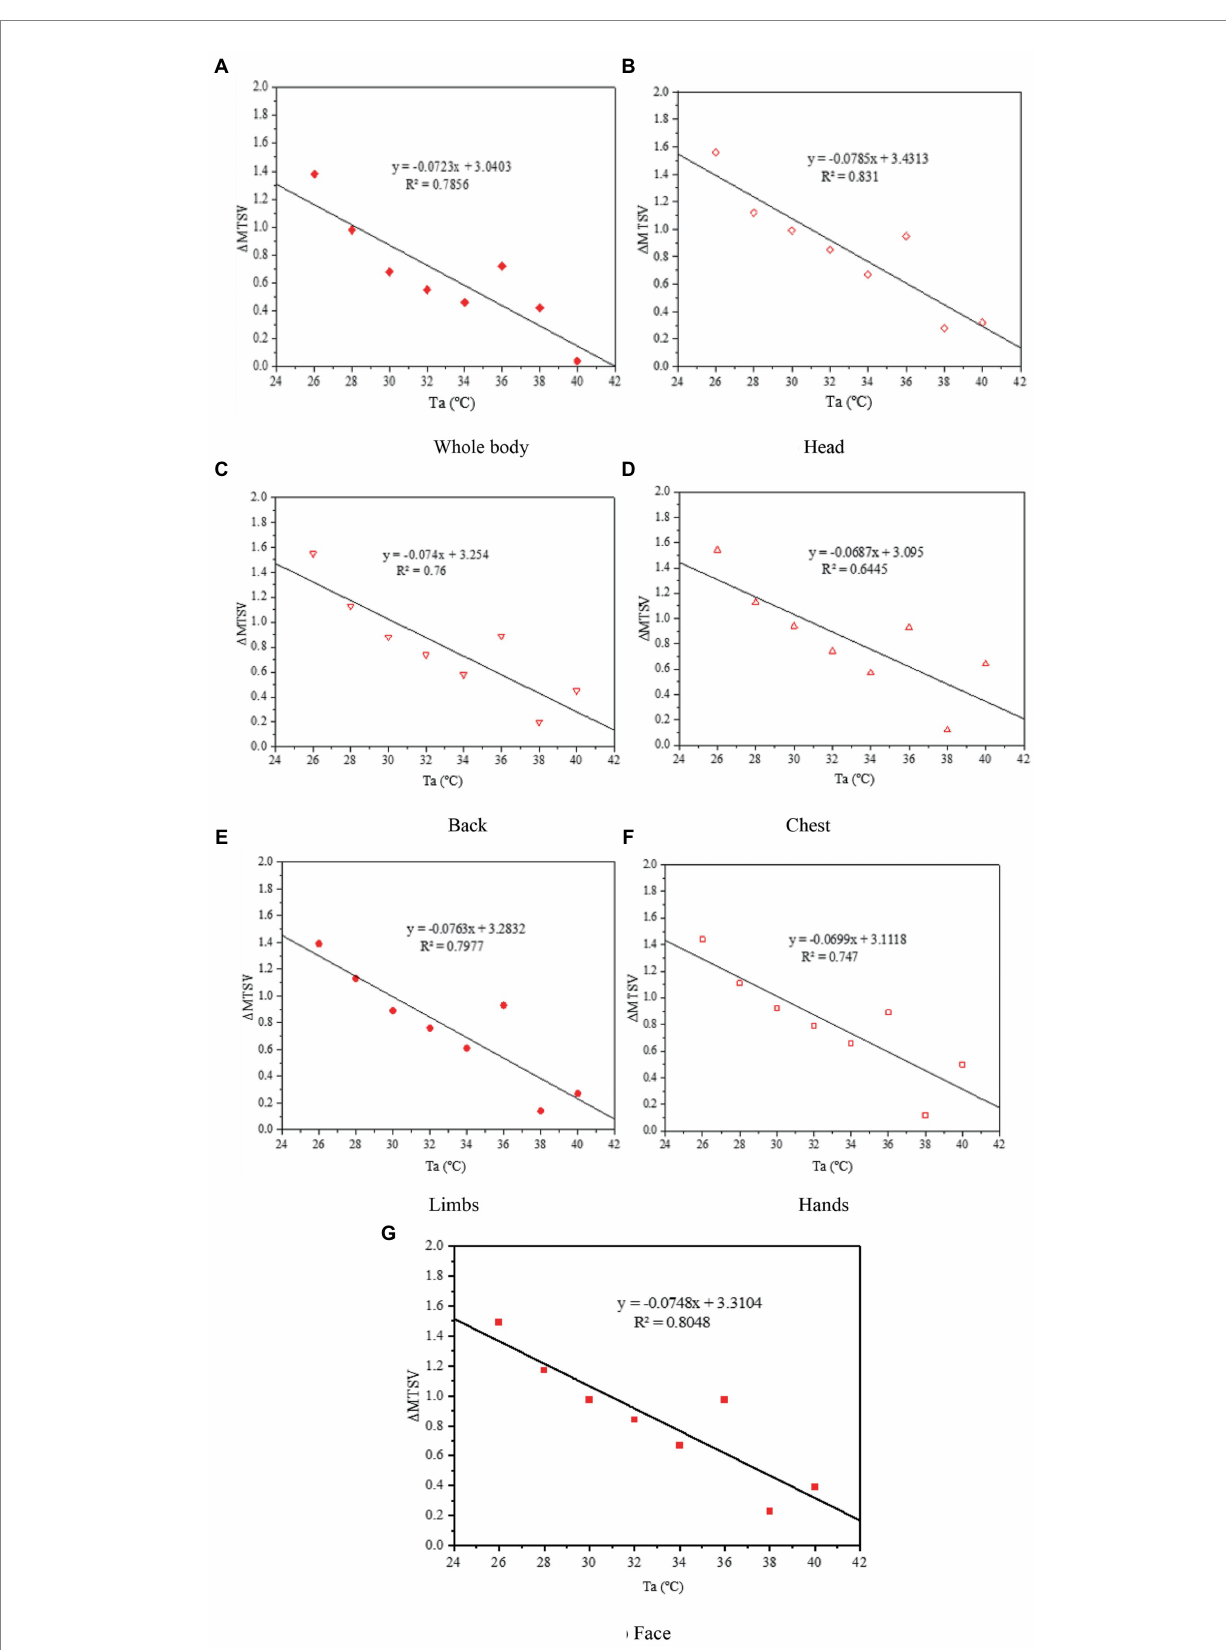
FIGURE 9 Variations in Δ MTSV against T a . Δ MTSV, change in the mean thermal sensation vote; T a , air